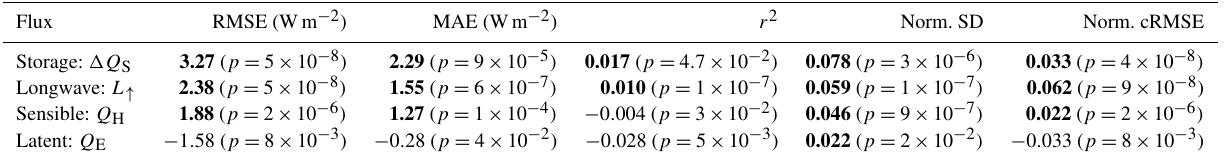
Figure 7. A Taylor diagram of energy fluxes for each simulation with interface scheme (filled markers) and half-layer scheme (unfilled markers) connected by a line. Change toward a normalised standard deviation of 1 indicates improved variance (radial distance) and toward the bottom axis indicates improved pattern correlation (radial angle). Where both are improved, the centred root mean square (cRMSE) error decreases towards zero (interior arcs). Different colours indicate different material parameter datasets (SITE, WRF, UZE, aTEB; see Ap- pendix A). Different marker shapes indicate different aerodynamic heat transfer parameterisations (Rowley, Harman, Jüges; see Appendix C). Anonymous results of participants in the PILPS-urban Phase 2 intercomparison are also plotted (Grimmond et al., 2011). Overall the inter- face scheme improves storage heat, sensible heat and longwave radiation fluxes. Latent heat flux response is less clear, but on average the interface scheme degrades performance. See Table 3 for summary statistics. Table 3. Average performance statistics: change from half-layer to interface scheme for 12 pairs of experiments (improvement in bold). The significance value ( p ) of a paired, two-sided t test for the null hypothesis is given in parentheses; in all cases the 95% confidence level is